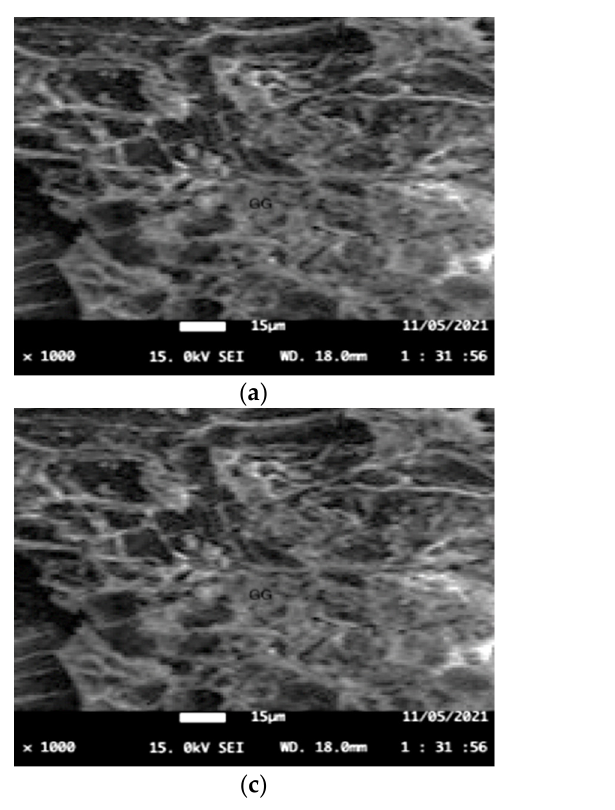
Figure 8. SEM images of the fresh CPAC ( a , c ) and spent CPAC applied for both wastewater ( b ) and Milli-Q water ( d